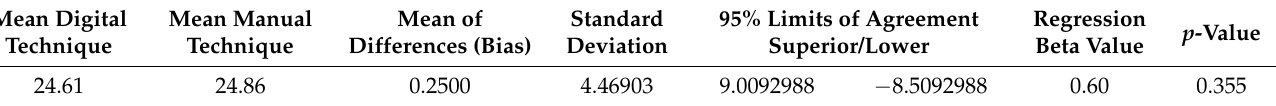
Table 7. Bland–Altman analysis.